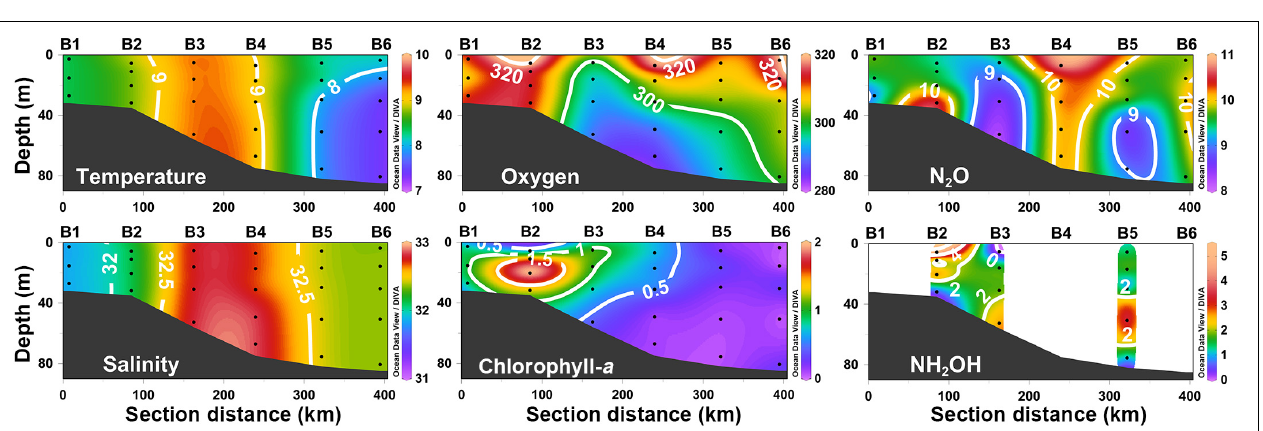
FIGURE 2 | The surface physical and biogeochemical distributions in the SYS and the ECS: (A) temperature ( ◦ C); (B) salinity (psu); (C) dissolved oxygen ( µ mol L − 1 ); (D) chlorophyll- a ( µ g L − 1 ); (E) N 2 O (nmol L − 1 ); (F) NH 2 OH (nmol L − 1 ); and (G) N 2 O saturation (%).